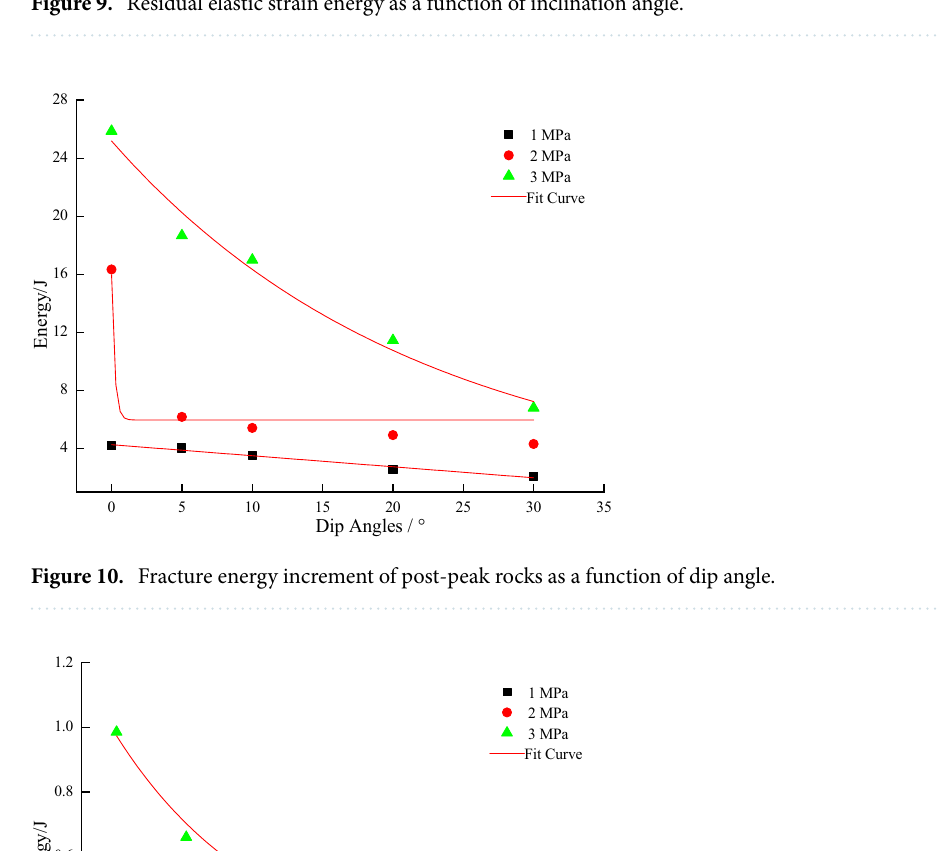
Figure 9. Residual elastic strain energy as a function of inclination angle.